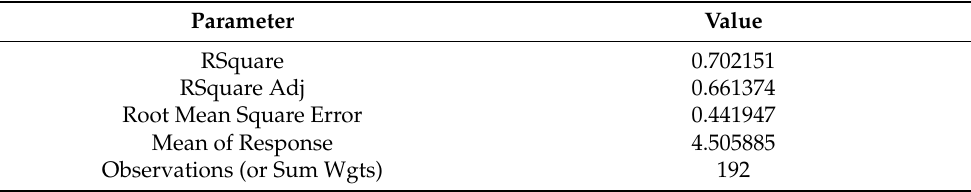
Table 4. The summary statistics of nonlinear model of the Basel AML